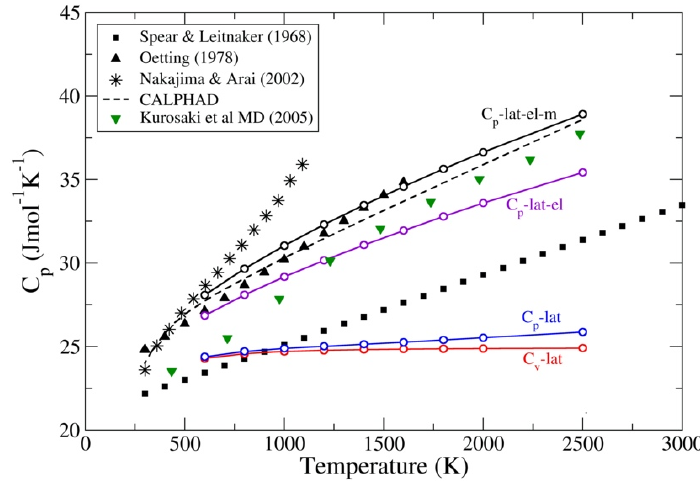
Figure 12. Specific heat at constant pressure, C p , for PuN. The levels of theory are indicated by open circles. The connecting lines are guide for the eye only. Experimental data [13,78,79] are shown as solid black symbols, the semi-empirical molecular-dynamics (MD) simulations [9] as green triangles, and CALPHAD data with a dashed line.